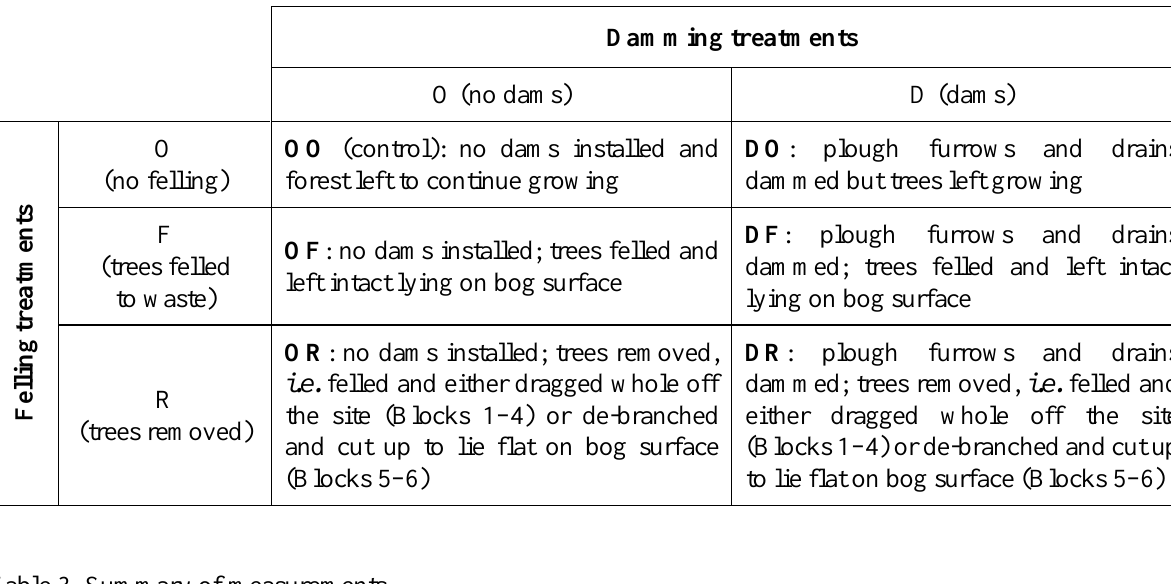
Table 3. Summary of measurements.